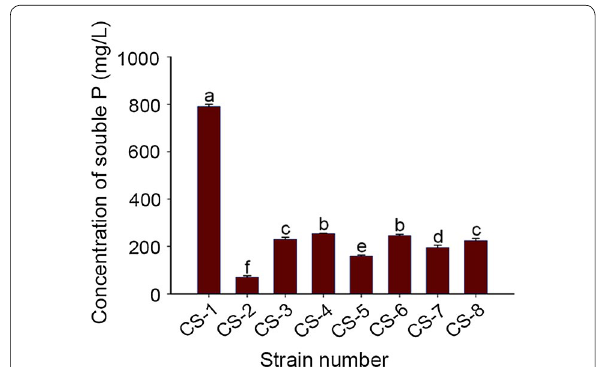
Fig. 1 Evaluation of the phosphate solubilising ability of the selected fungi in NBRIP medium. Soluble phosphorus (P) accumulation in cultures of different fungal strains grown on NBRIP medium. Error bars indicate standard errors (n 3). Columns with different letters = are significantly different ( P < 0.05) according to the Student’s t